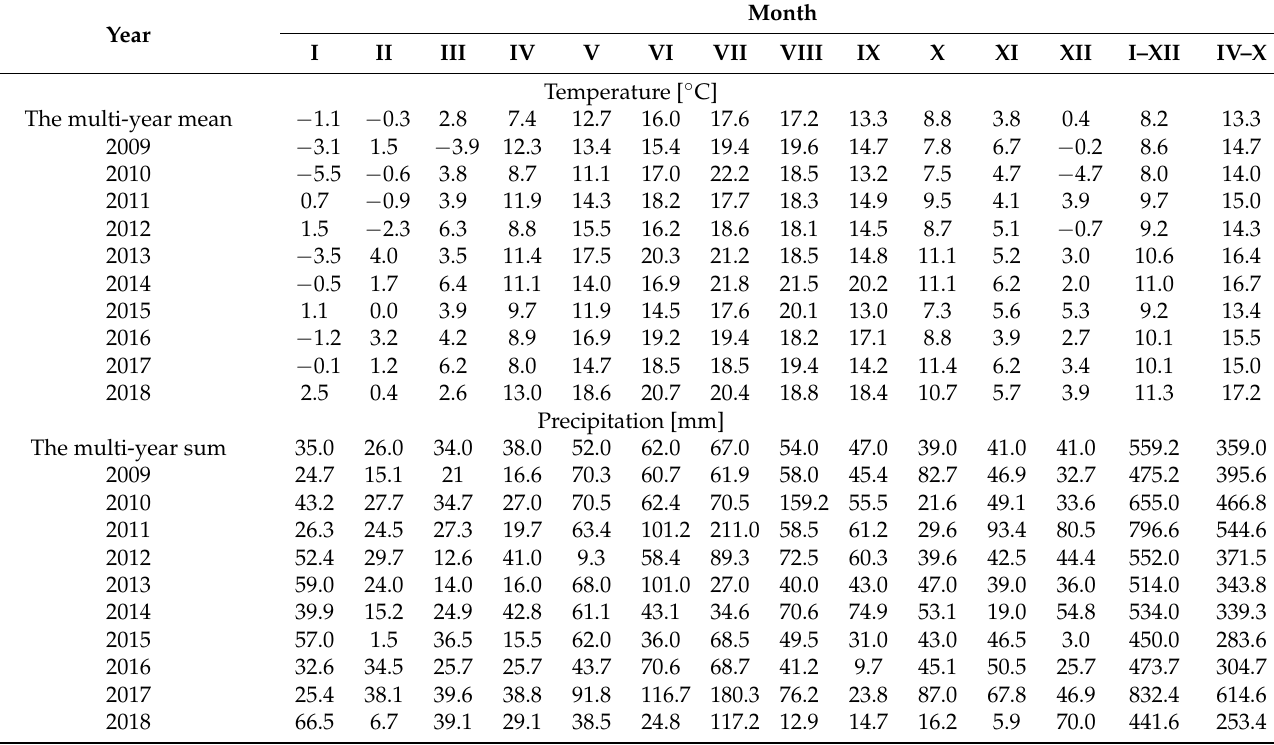
Table 1. The average monthly air temperature ( ◦ C) and monthly sum of precipitation